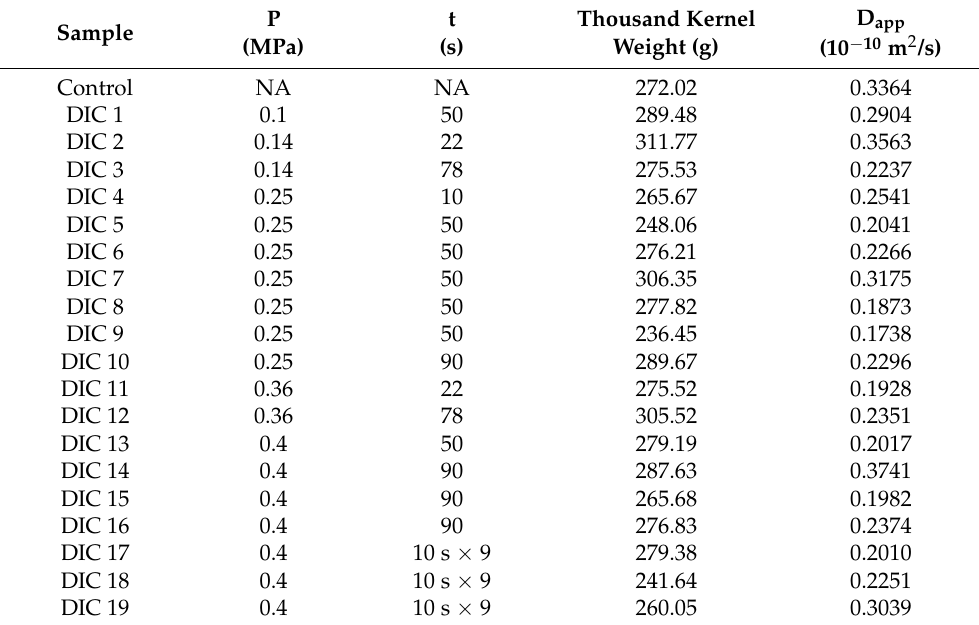
Table 2. Effect of DIC treatment on the thousand kernel weight and apparent drying coefficient of maize kernels.